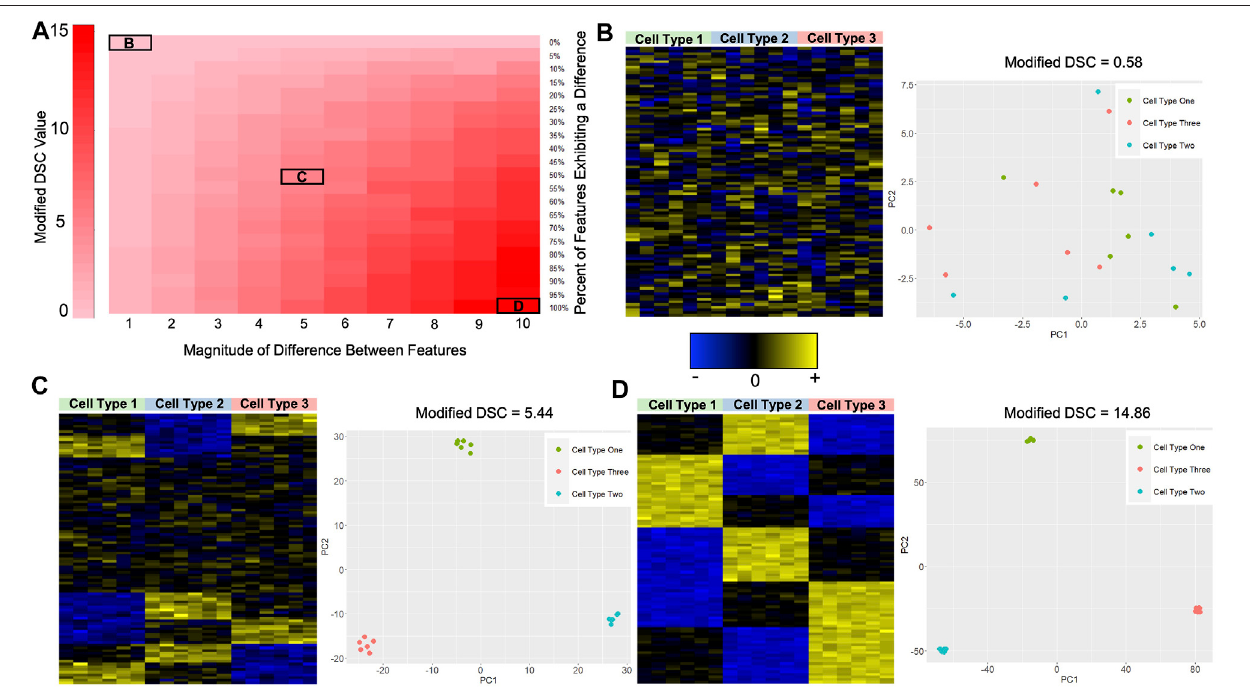
FIGURE 3 | Proof-of-Principle Illustration of the Modi fi ed DSC Metric. (A) Heat map showing the value of the Modi fi ed DSC under the different data scenarios as described in section 2.5.1 . The y -axis shows the percent of features that were simulated to exhibit a difference in the mean feature(s) value across cell types, and the x -axisre fl ectsthemagnitudeofthedifferencebetweenthemeanfeature(s)valuesacrosscelltypes.DarkerredindicateshighervaluesoftheModi fi edDSC. (B) Heatmap and PCA plot for the simulated data where no features exhibited a difference in the mean feature(s) values across cell types. The value of the modi fi ed DSC for this simulated data is also provided. (C) Heat map and PCA plot for the simulated data where 50% ofthe features exhibited a difference in mean feature(s) values across cell types with a magnitude of 5 (i.e., Δ (cid:1) 5). The value of the modi fi ed DSC for this simulated data is also provided. (D) Heat map and PCA plot for the simulated data where 100% of the features exhibited a difference in the mean feature(s) values across cell types with a magnitude of 10 (i.e., Δ (cid:1) 10). The value of the modi fi ed DSC for this simulated data is also